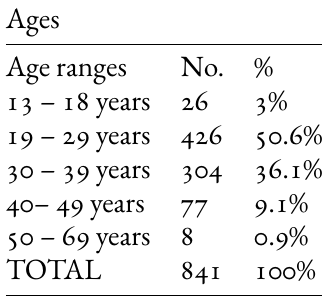
Table 1. Source: Own